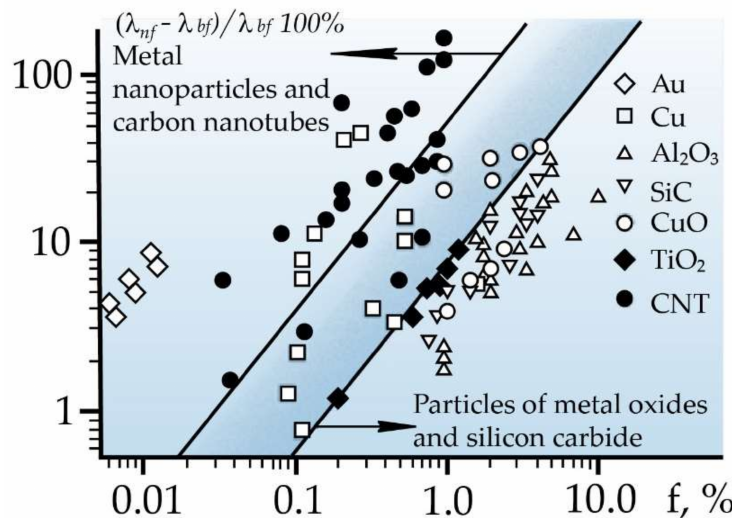
Figure 3. Dependence of the relative thermal conductivity coefficient of nanofluids on the volume concentration (f,%) of various types of nanoparticles: λ nf and λ bf thermal conductivity coefficients of the nanofluid and the base fluid [16].